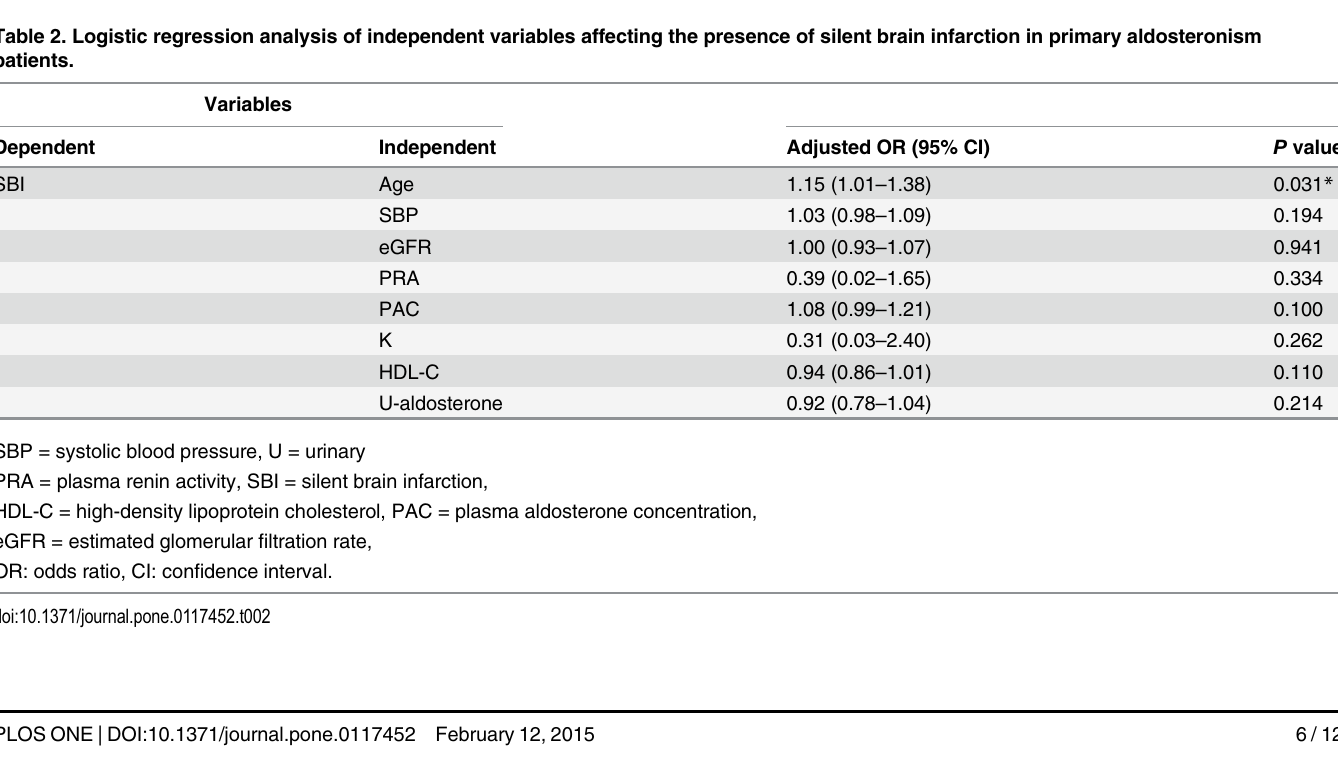
OR: odds ratio, CI: con fi dence